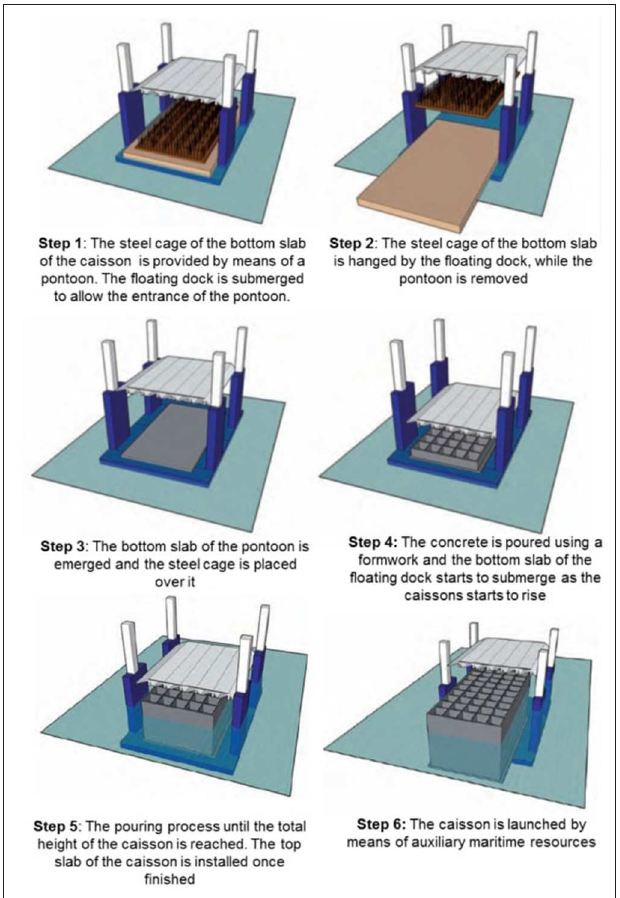
FIGURE 6 | The process of building a caisson using a floating dock. Adapted from Puertos del Estado (Puertos del Estado, 2008).